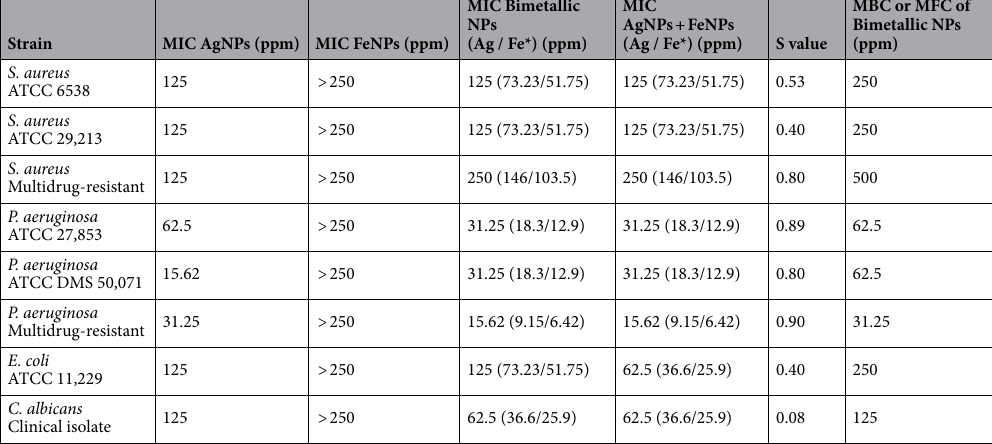
Table 1. Minimal Inhibitory Concentration (MIC), S value, Minimum Bactericidal Concentration (MBC) and Minimum Fungicidal Concentration (MFC) of silver nanoparticles (AgNPs), iron nanoparticles (FeNPs), Ag-Fe bimetallic nanoparticles, and combination of AgNPs + FeNPs, prepared using Gardenia jasminoides leaves aqueous extract against clinically relevant pathogens. *The elemental composition of Ag and Fe was considered to analyze nanoparticles’ antimicrobial activity (bimetallic and AgNPs + FeNPs): 58.59% of Ag and 41.4% of Fe. S value: S > 0 Synergistic; S = 0 Additive; S < 0